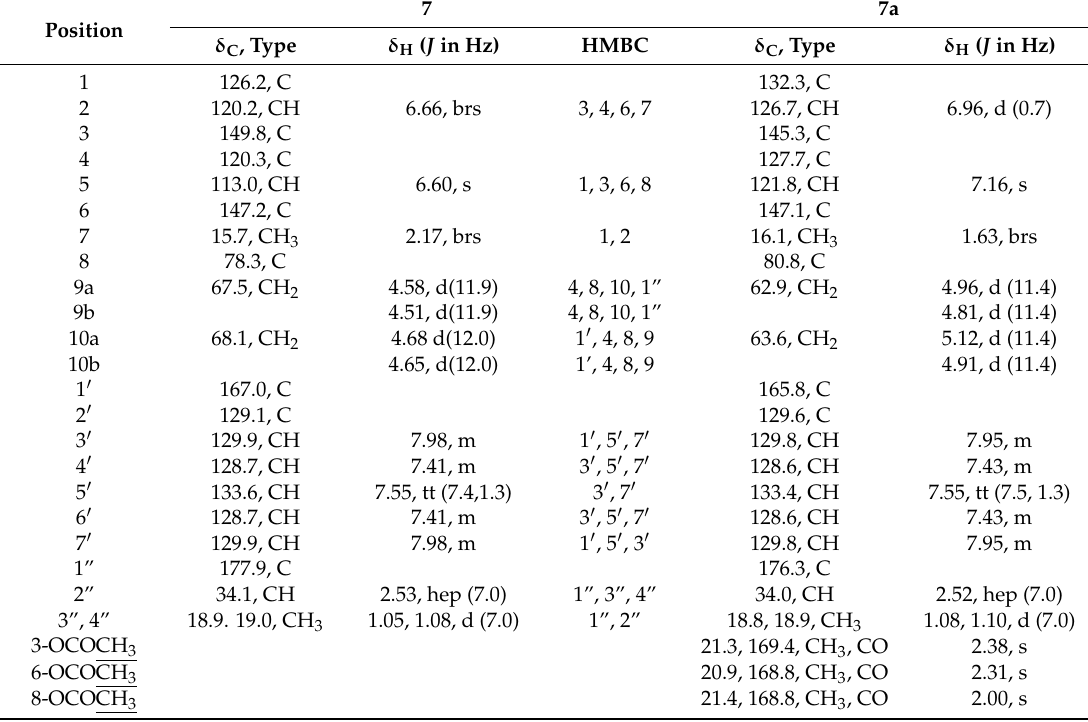
Table 4. NMR spectroscopic data ( 1 H 400 MHz, 13 C 100 MHz, CDCl 3 ) of 7 and 7a